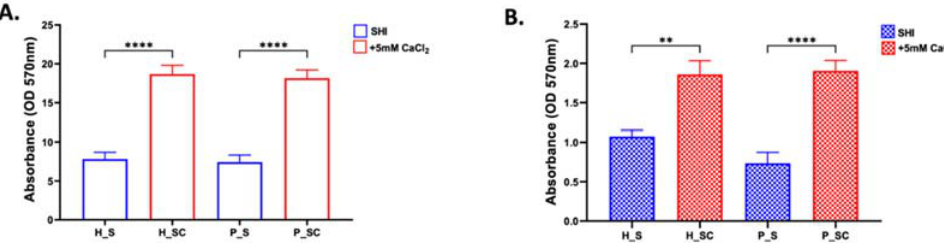
Figure 3. Effect of calcium ion supplementation on biofilms derived from the saliva of periodontally healthy (H) and periodontitis (P) patients. The biofilms were grown in SHI medium (blue bars) and SHI medium + 5 mM CaCl 2 (red bars) for five days. The bar plots representing the mean and standard deviation of three independent experiments performed in triplicate are shown. ( A ) Biofilm biomass: as assessed by measuring crystal violet at the optical density of 570 nm. ( B ) Biofilm metabolic activity: measured by optical density of formazan formation from MTT at 570 nm. ** Represents p ≤ 0.01, and **** represents p ≤ 0.0001.